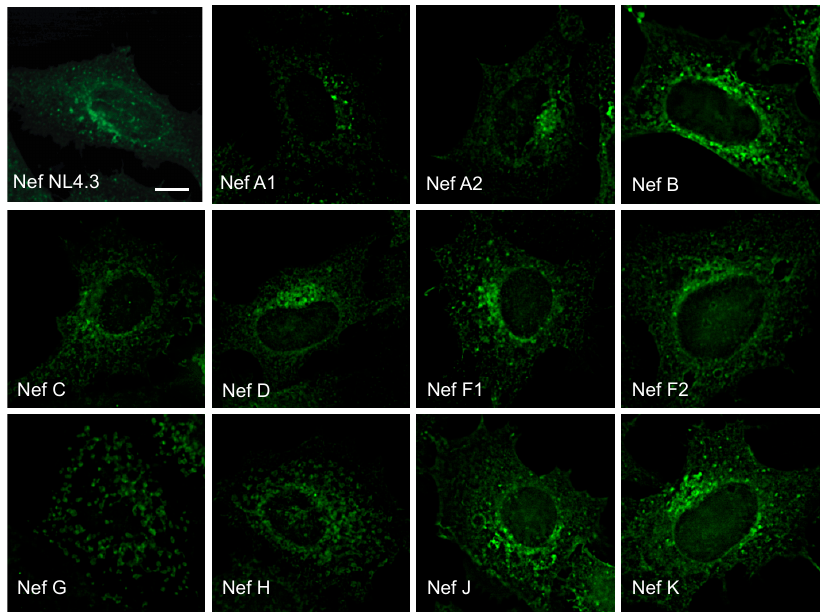
Figure 2. Differing subcellular distribution of Nef proteins from reference strains of HIV-1 group-M subtypes. CD4 HeLa cells were transfected with various plasmids encoding eGFP-tagged Nef proteins from reference strains of different HIV-1 subtypes (A through K). Cells were fixed in 4% paraformaldehyde and imaged on a Leica DMI6000 B widefield microscope on the 100× objective. (scale bar = 10 μ m. Green = Nef–eGFP).